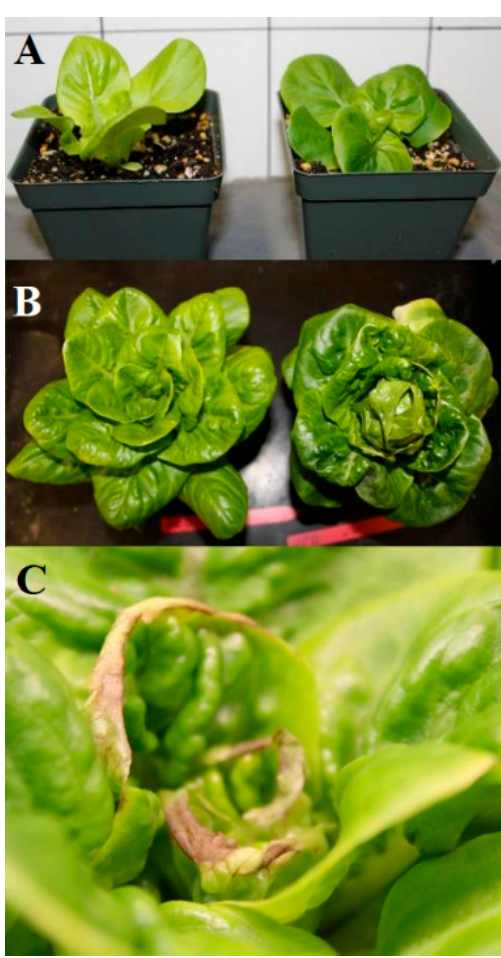
Figure 2. Pictures of lettuce grown in second experiment. Visual appearance of lettuce plants grown under 10 h (left) and 20 h (right) photoperiods with the same daily light integral of 16 mol · m − 2 · d − 1 at ( A ) 21 and ( B ) 41 days after planting; ( C ) tip burn on inner leaves of lettuce plant.